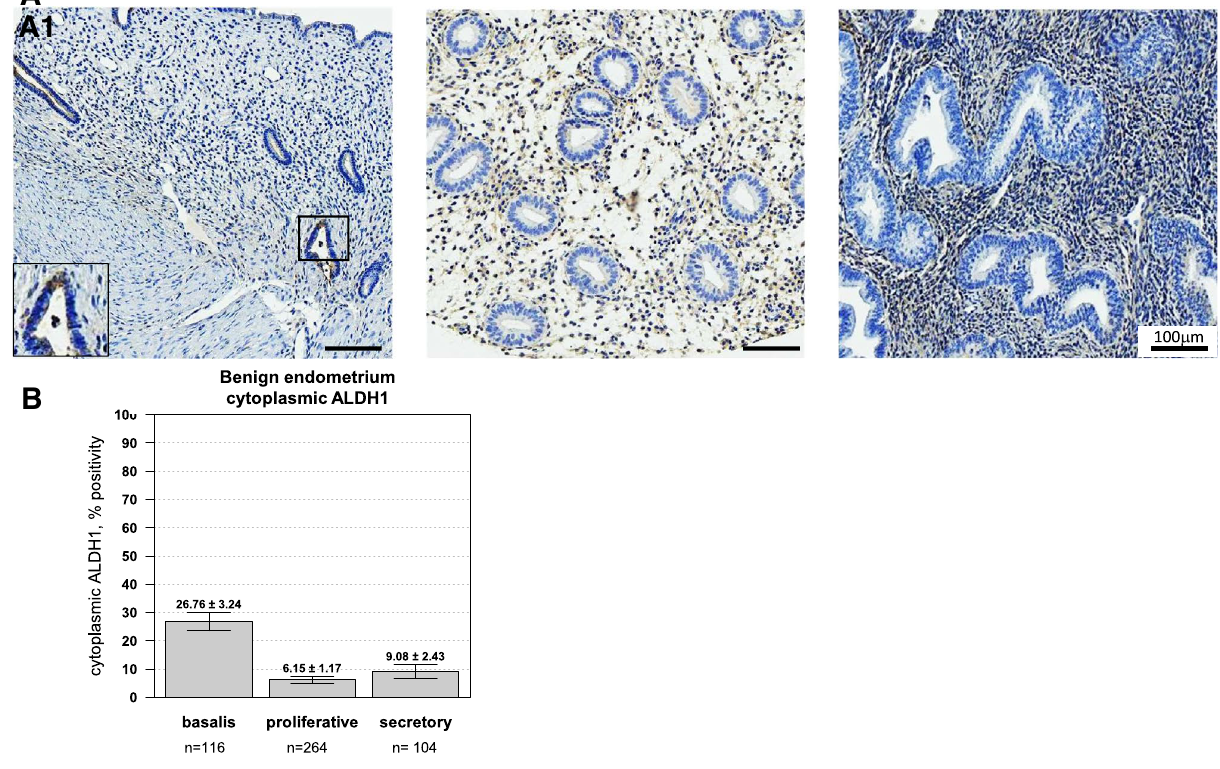
Figure 3. ALDH1 is expressed within the basal layer of the endometrium. ( A ) Representative cores representing the stratum basalis ( A1 ) compared to proliferative ( A2 ) or secretory ( A3 ) endometrium. All images are 100X. The percentage of glands with positive expression were scored. In benign endometrial tissue, ( B ) Cytoplasmic ALDH1 expression was observed in endometrial glands of the stratum basalis (26.76 ± 3.24, n = 116 cores) compared to both proliferative and secretory endometrium (Kruskal–Wallis p value = 1.145e−14). Significantly lower expression of ALDH1 was observed in the proliferative phase (6.15 ± 1.17, n = 264 cores) and in the secretory phase (9.08 ± 2.43, n =